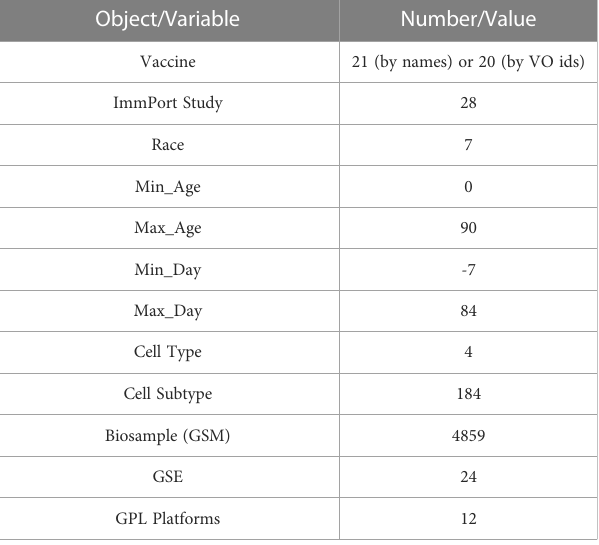
TABLE 1 Statistics of the vaccine response gene expression data collected based on ImmPort